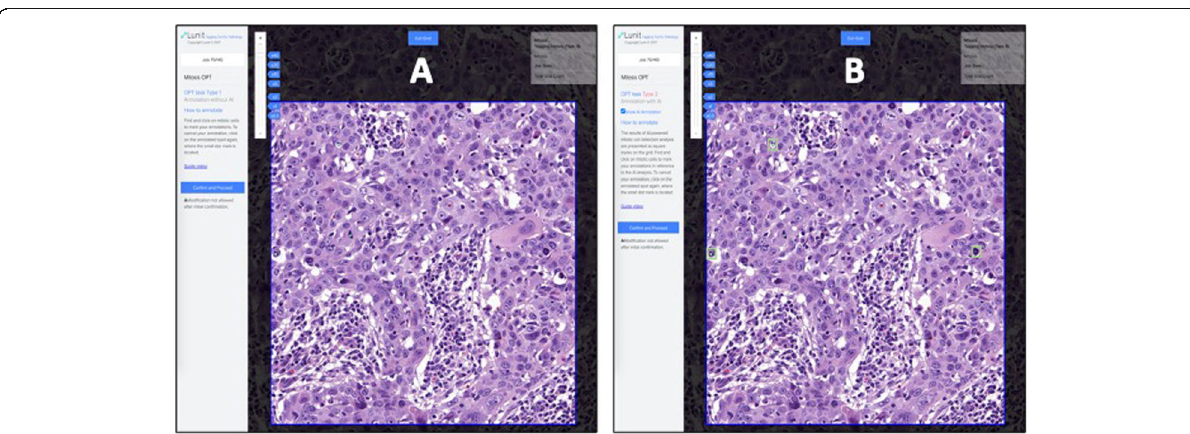
Fig. 2 Web-based tool showing a HPF of breast carcinoma. a Screenshot of the web-based tool used for the observer performance test without AI. The small green dots indicate mitotic figures marked by the reader. b Screenshot of the web-based tool used for the observer performance test with AI. The green boxes indicate mitotic figures detected by